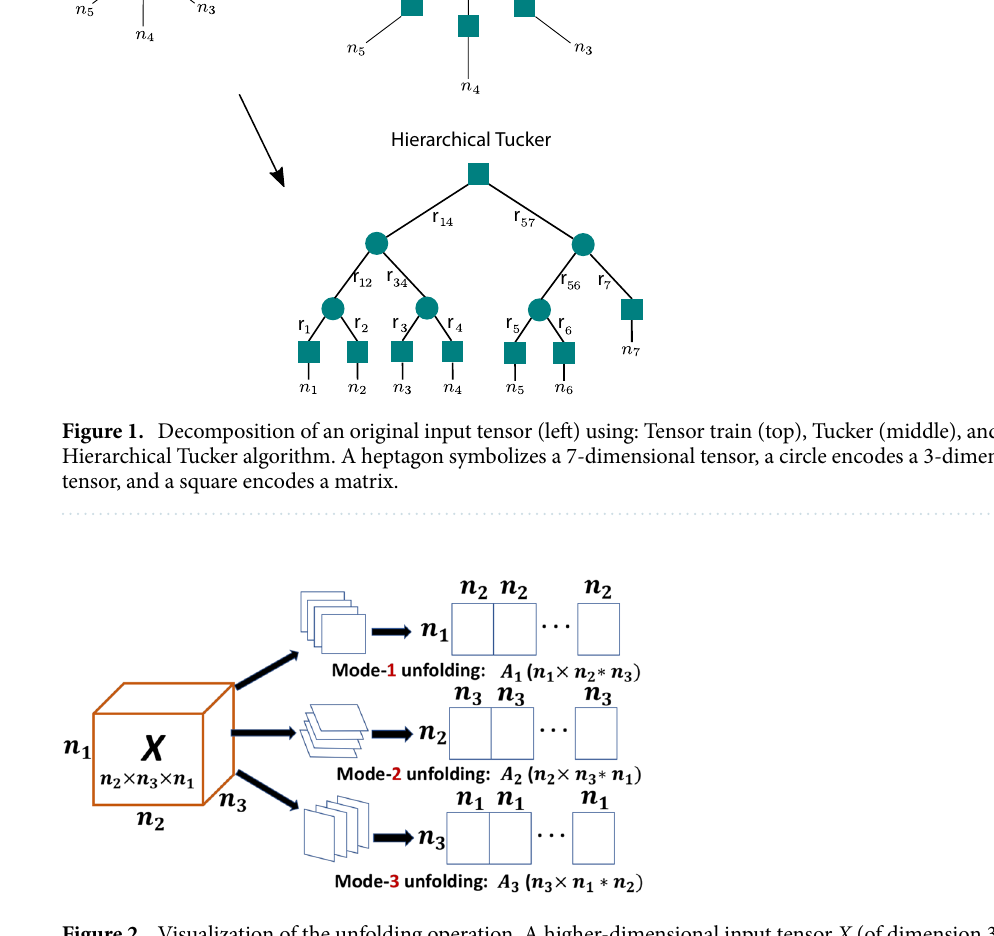
Figure 2. Visualization of the unfolding operation. A higher-dimensional input tensor X (of dimension 3 in the example) is unfolded into a matrix by “stitching” it together alongside any of the 3